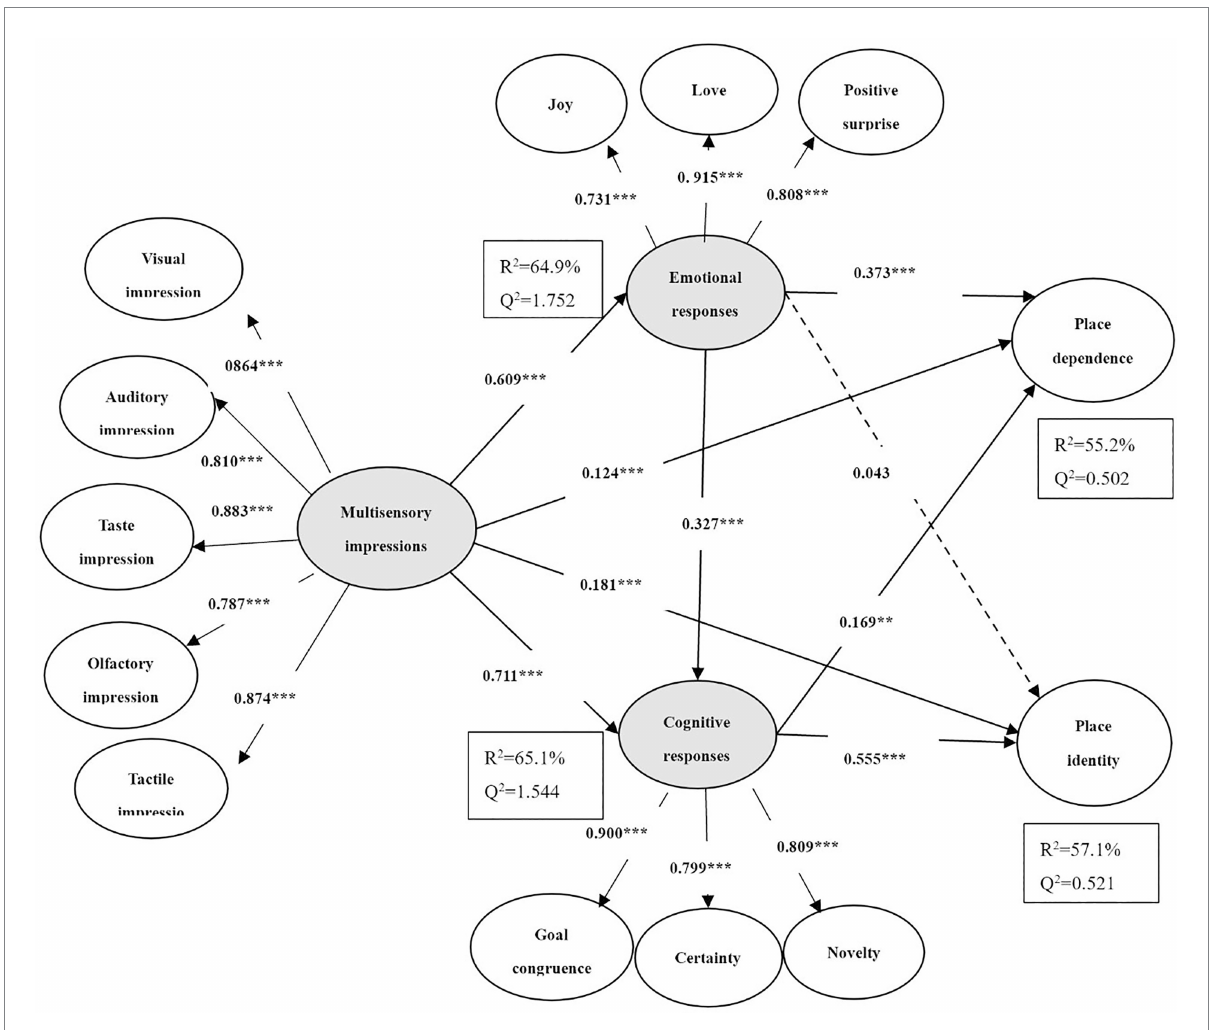
FIGURE 2 Conceptual model for repeat tourists. * indicates significance at p < 0.05; ** indicates significance at p < 0.01; and *** indicates significance at p <